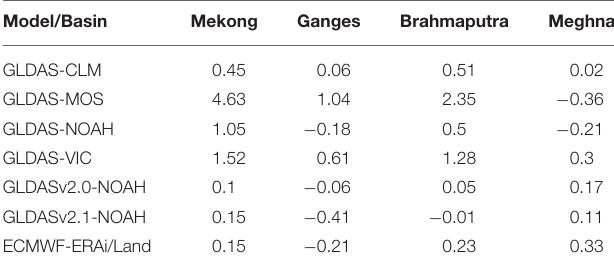
TABLE 2 | Mean annual error in model water budget with respect to the input precipitation (%).